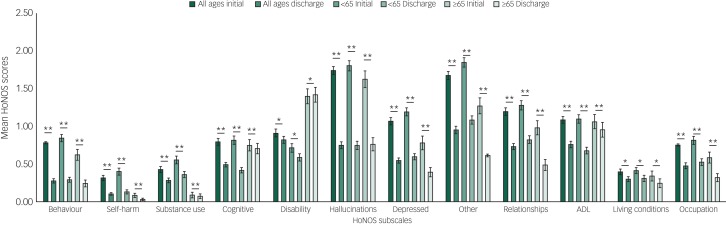
Psychosis disorder group: mean Health of the Nation Outcomes Scales (HoNOS) scores on initial assessment and discharge across the 12 HoNOS subscales.